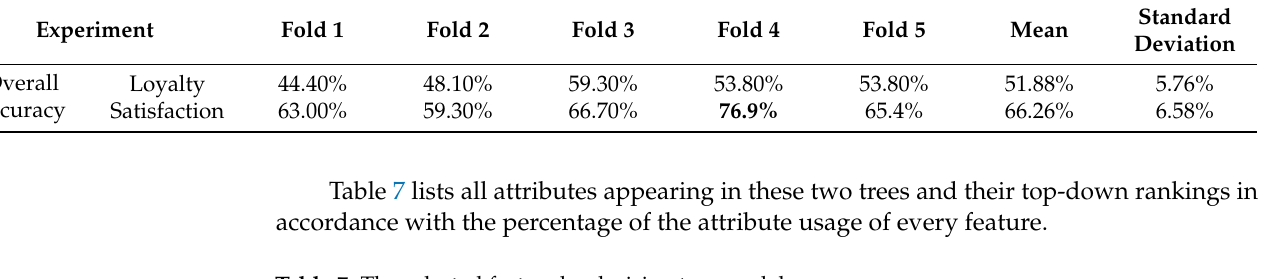
Table 7. The selected factors by decision tree model.